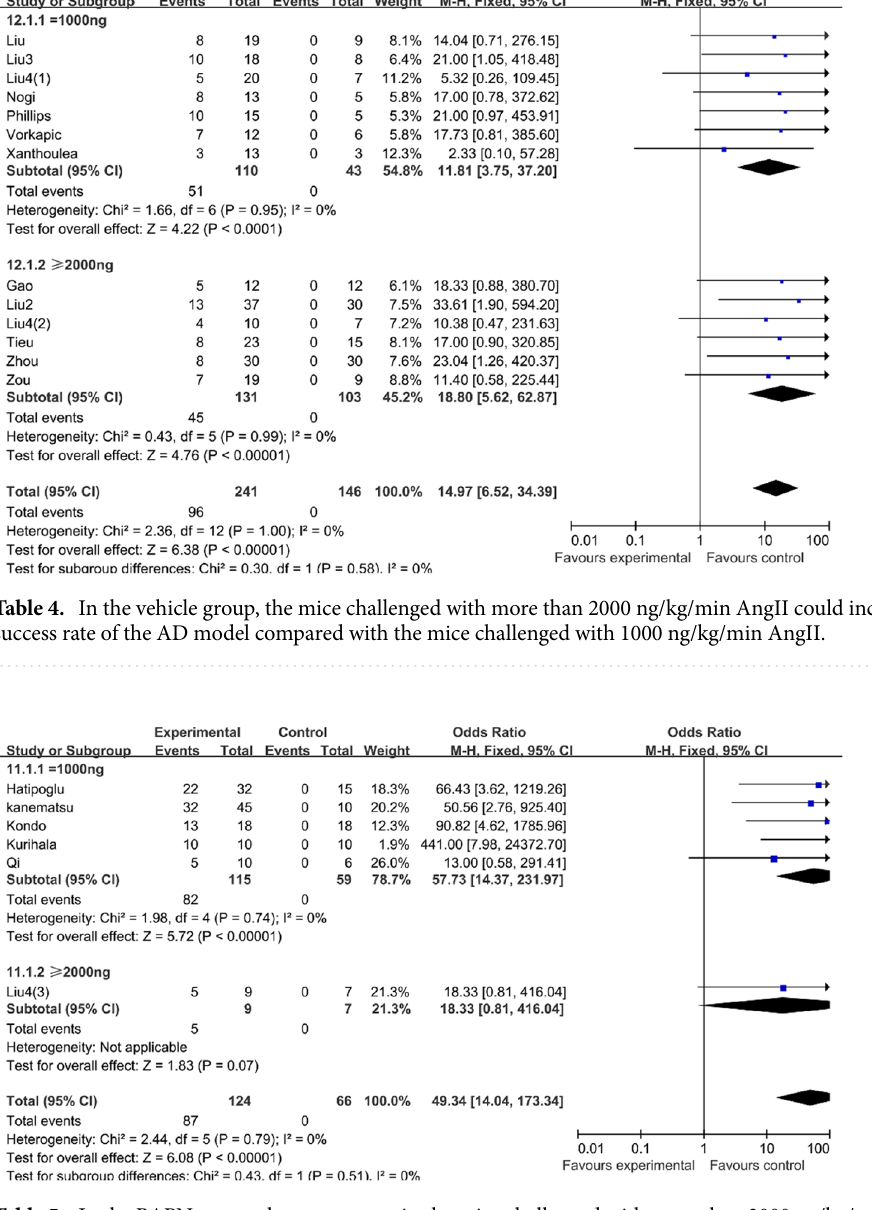
Table 5. In the BAPN group, the success rate in the mice challenged with more than 2000 ng/kg/min AngII decreased compared with the mice challenged with 1000 ng/kg/min